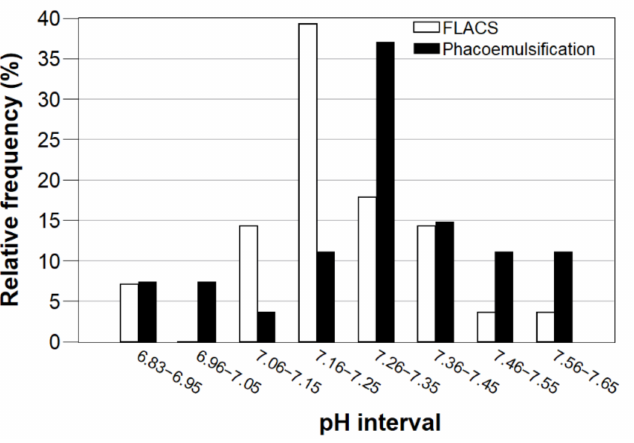
Figure 9. Relative frequency distribution of aqueous humor pH for FLACS and